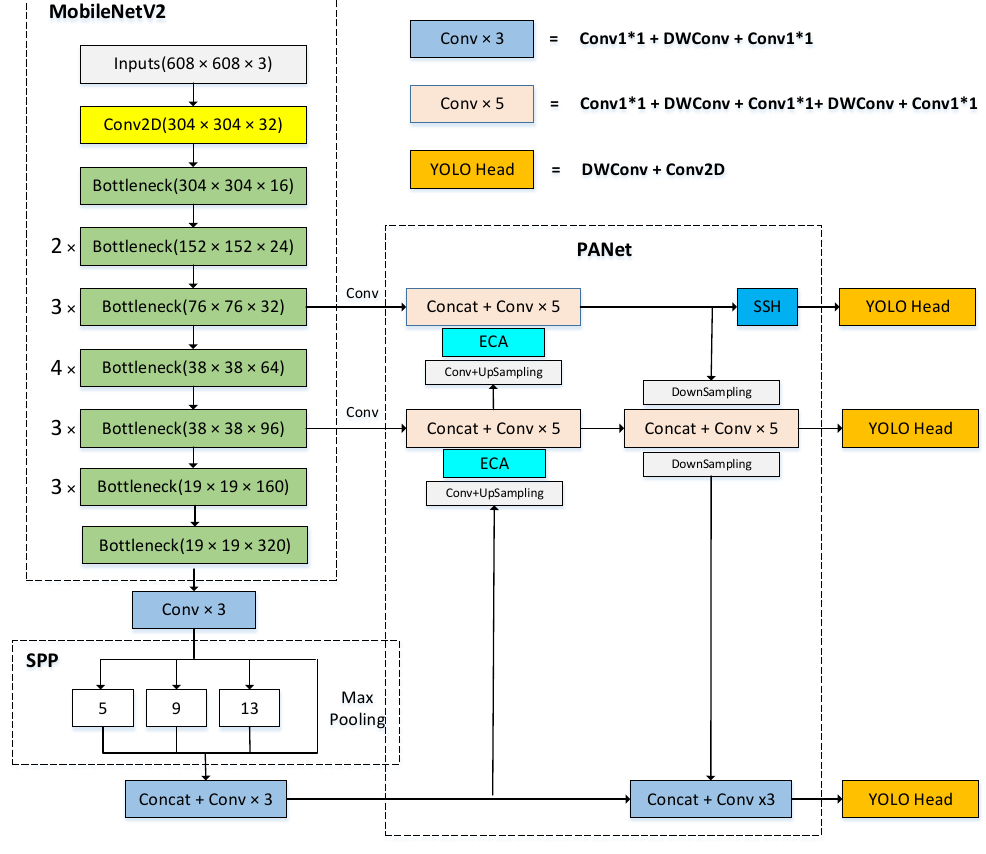
Figure 2. MobileYOLO model